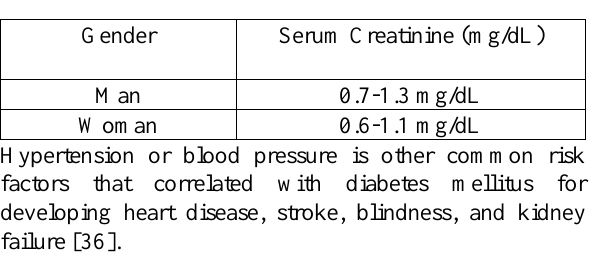
Table 3. Investigation ranges of chronic kidney disease.